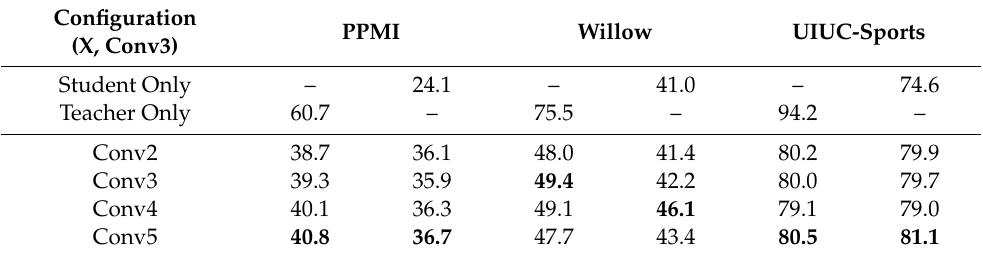
Table 4. Classification accuracy (%) of the Auxiliary Structure Learning (ASL) network. For each dataset, the first column is for the teacher network and the second column is for the student network. Di ff erent layers of the teacher network are bound to the Conv3 layer in the student network. (X, Conv3) indicates that X layer of the teacher network is used to bind Conv3 of the student network. The number marked in bold indicates the layer with the highest